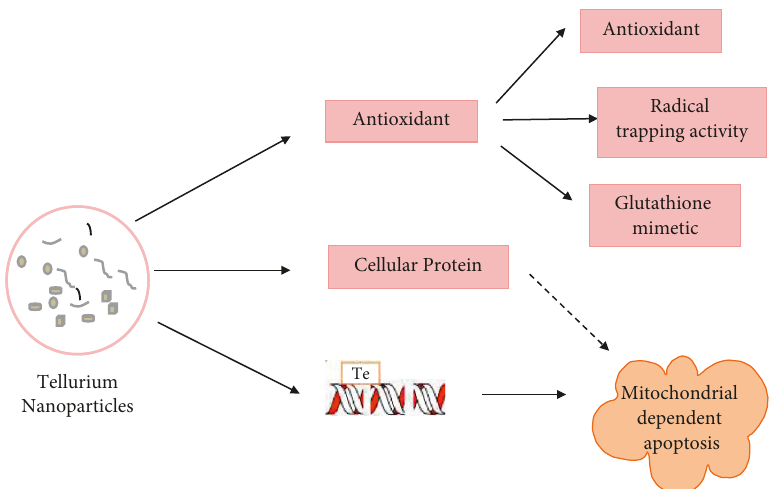
Figure 5: Anticancer mechanism of tellurium nanoparticles.